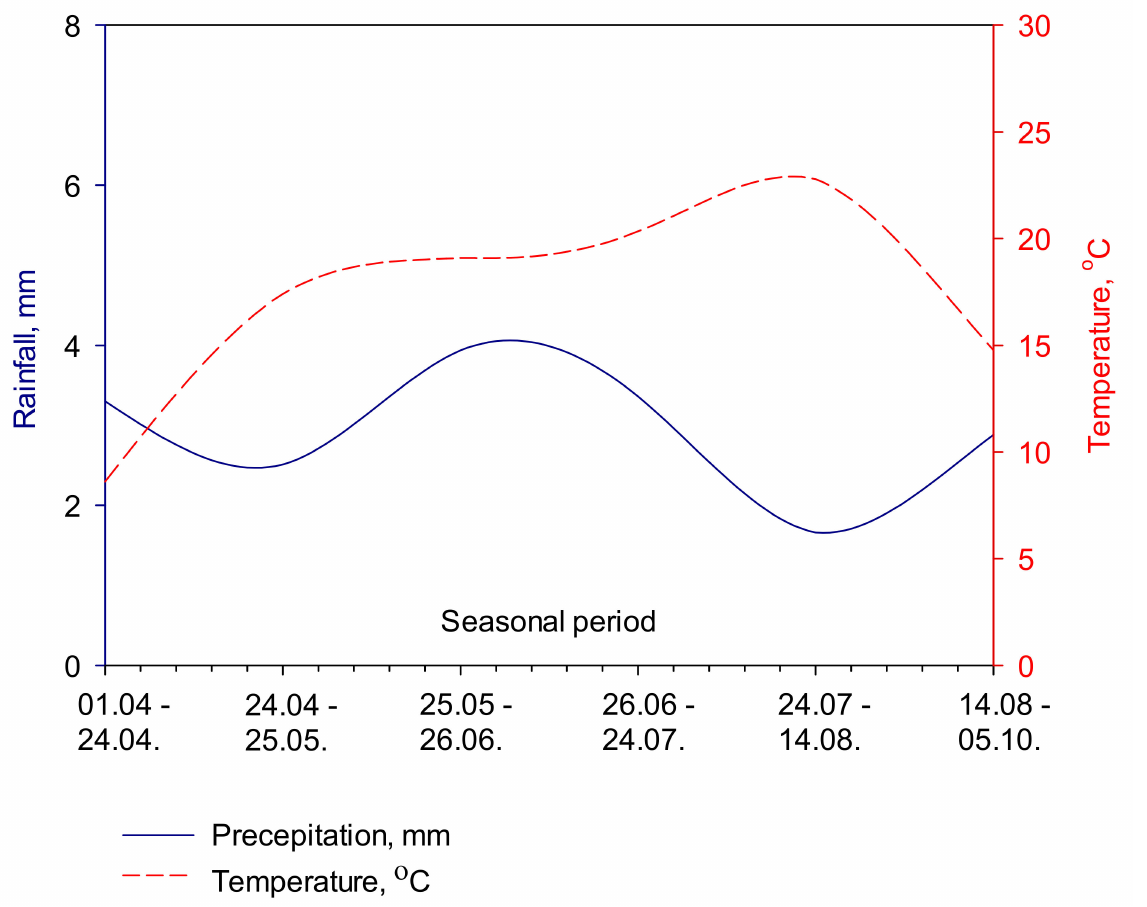
Figure 6. Mean rainfall and temperature parameters during different seasonal periods at the Velykos- nyatynky research station, 2012–2014. Table 2. Spearman’s correlation coefficients between soil and climatic